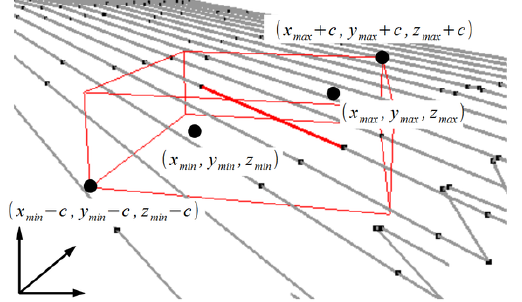
Figure 6: Definition of the AABB of a line